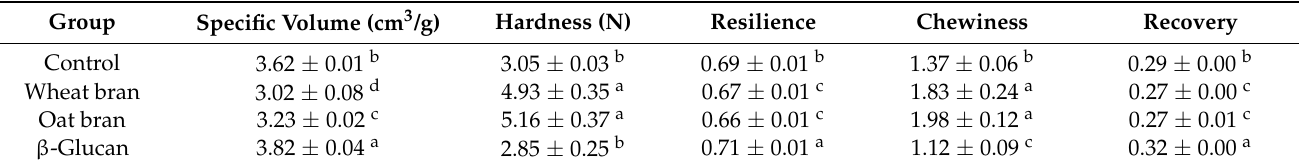
Table 2. Effects of different additives on the specific volume and texture properties of bread. Group Specific Volume (cm 3 /g) Hardness (N) Resilience Chewiness Recovery Control Wheat